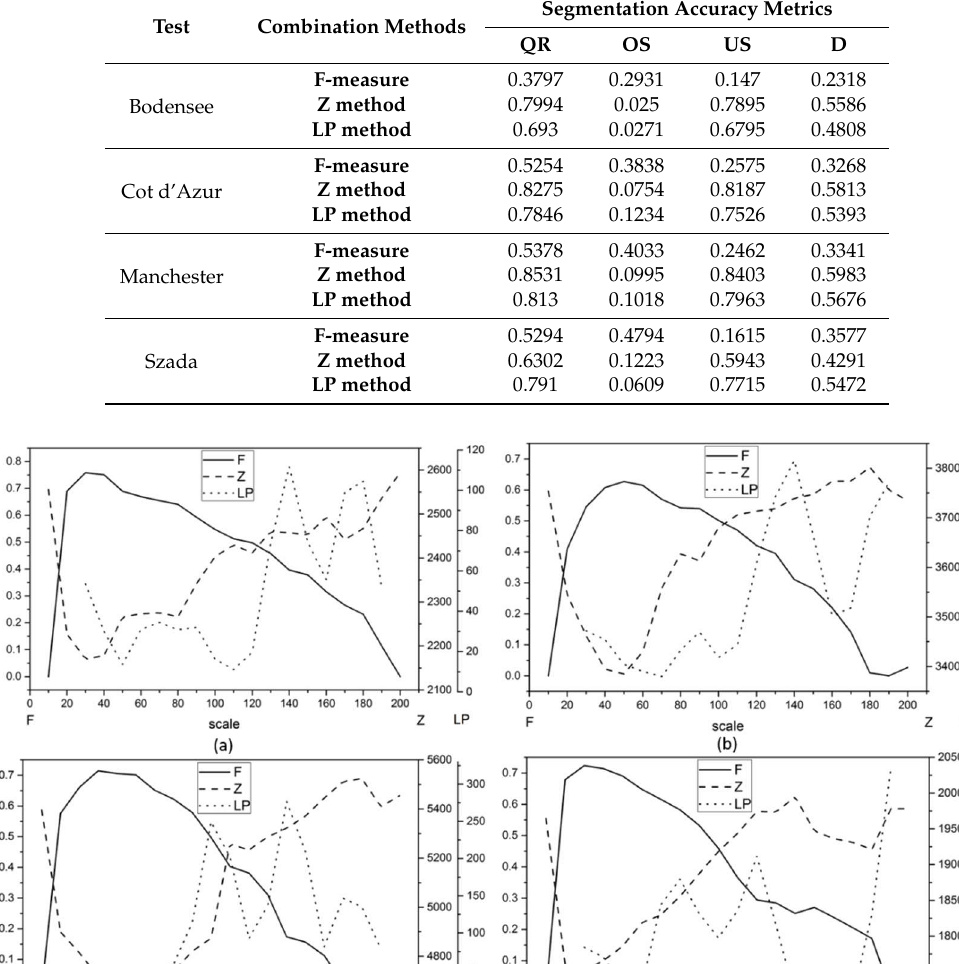
Table 3. The SE results for the segmentations produced with the three combination methods.